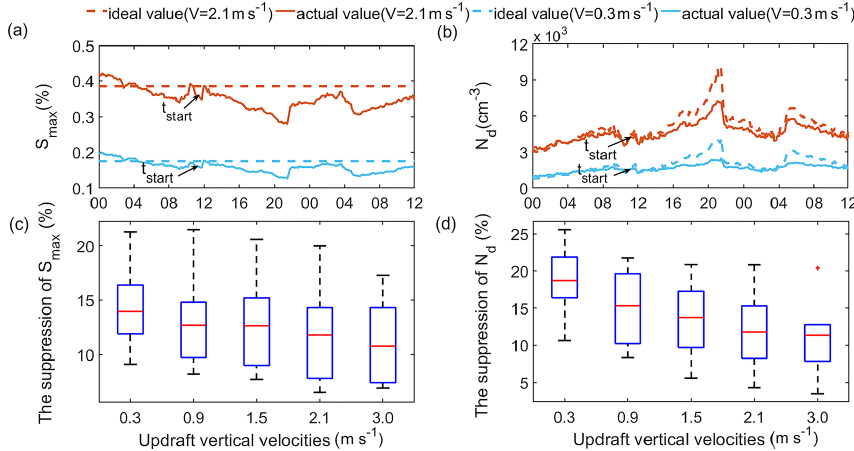
Figure 5. (a) The diurnal changes of the calculated maximum supersaturation ( S max ) (referring to the constant supersaturation S ) at V = 0 . 3 and 2.1ms − 1 on 11 June 2017. (b) Comparison of the cloud droplet number concentration ( N d ) under the constant S and S max on 11 June 2017. The suppression percentage of (c) S max and (d) N d due to the competition of water vapor.